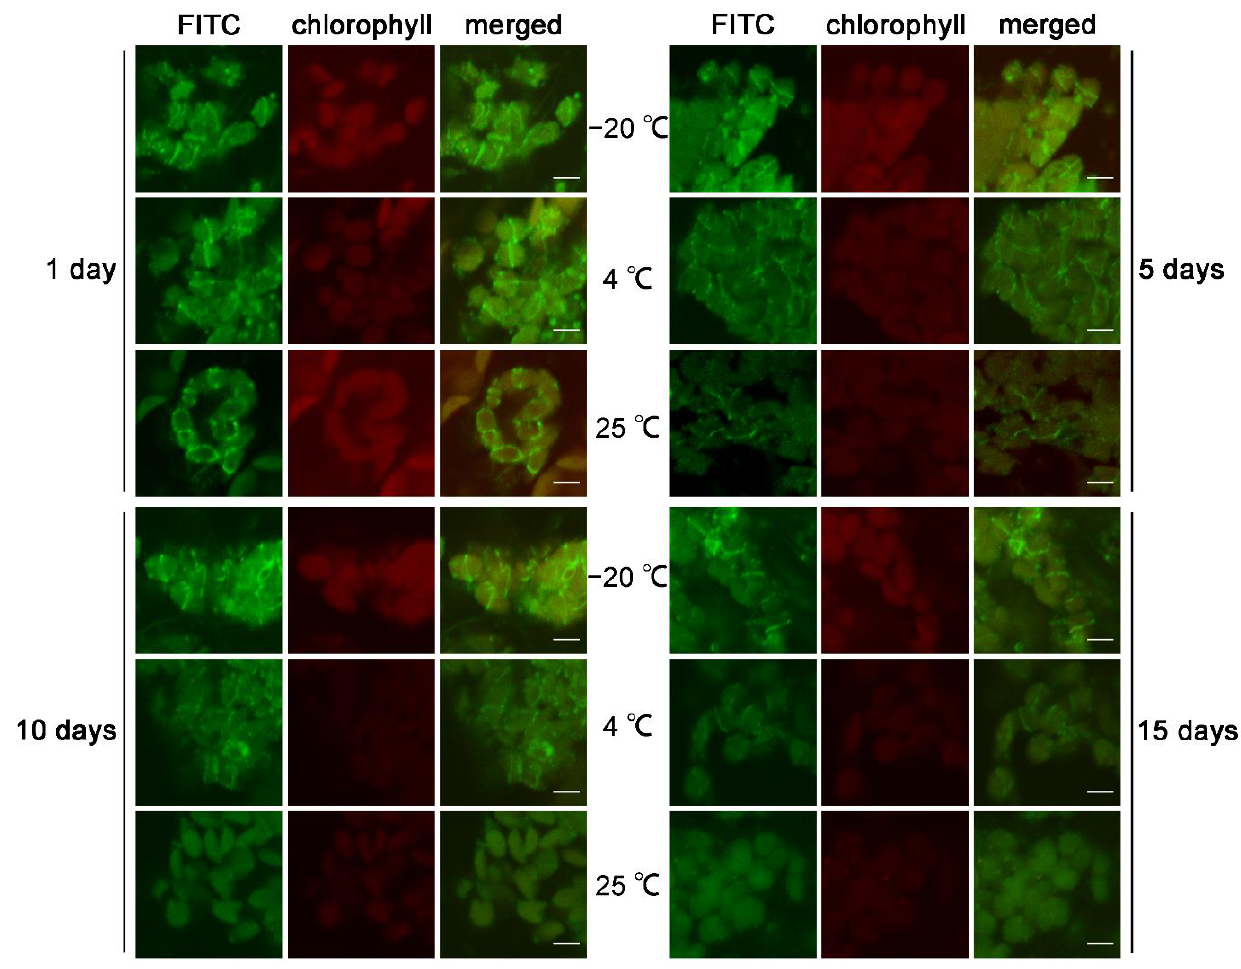
Figure 4. Storing at − 20 ◦ C prolongs the lifetime of the samples. The stained protein was FtsZ1. A comparison of the signal intensity for samples stored at − 20 ◦ C, 4 ◦ C, and 25 ◦ C on the 1st day, 5th day, 10th day, and 15th day of the storage. Images from these samples were captured with the same exposure condition. Bars = 5 μm.